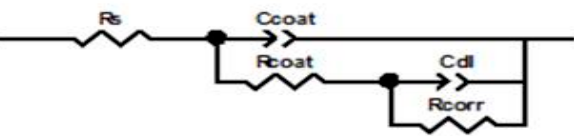
Figure 9. ( a ) Nyquist and ( b ) bode diagrams of the scratched samples immersed in the HCl solution for 8 days.